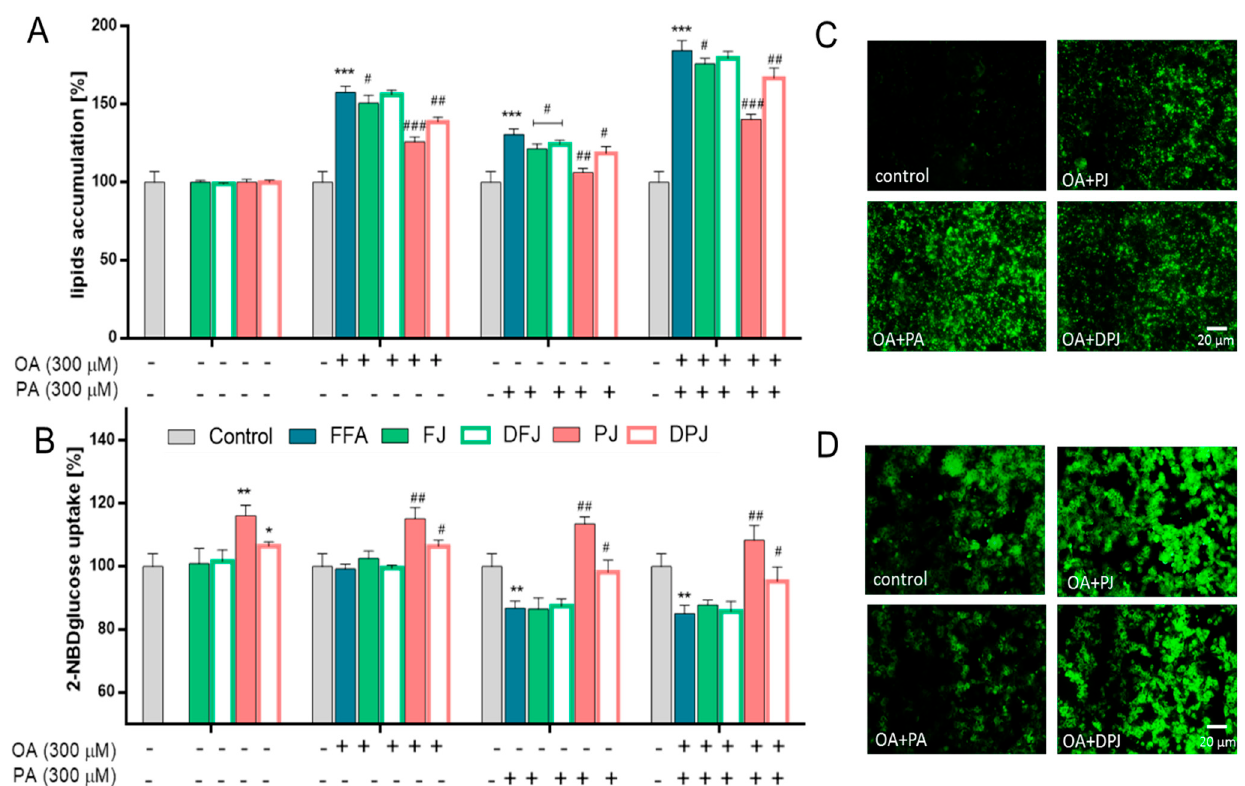
Figure 3. The influence of V. opulus fresh juice (FJ), digested fresh juice (DFJ), purified juice (PJ), and digested purified juice (DPJ) on the accumulation of lipid droplets ( A ) and the effect on fluorescent glucose analog 2-NBDG uptake ( B ) in HepG2 cells after 24 h co-incubation with 300 µM oleic acid and/or palmitic acid; control cells were not exposed to any compound except vehicle; values are means ± standard deviations from at least five independent experiments, n ≥ 9; statistical significance was calculated versus control cells (untreated), * p ≤ 0.05, ** p ≤ 0.01, *** p ≤ 0.001 and versus positive cells (treated with fatty acids), # p ≤ 0.05, ## p ≤ 0.01, ### p ≤ 0.001. Cells visualized under fluorescent microscope at 200× magnification with FITC filter after Nile Red staining ( C ) and after 2-NBDG uptake ( D ).